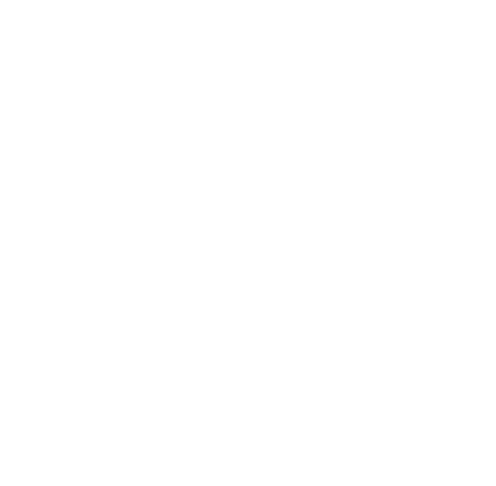
Figure 14. Average Nusselt number ( Nu av ) for the nanoparticles shape ( n ) and nanoparticles volume fraction ( ϕ ) when Ra = 10 6 , Ha = 30, d = 10 nm, n = 3, λ = 0.5, and τ = 1.